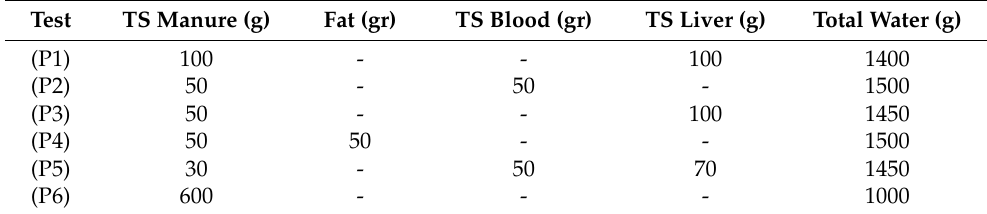
Table 1. Amounts imposed on the substrate for tests one to six. Table 2. Total values and percentage values of the solids and the humidity of the six